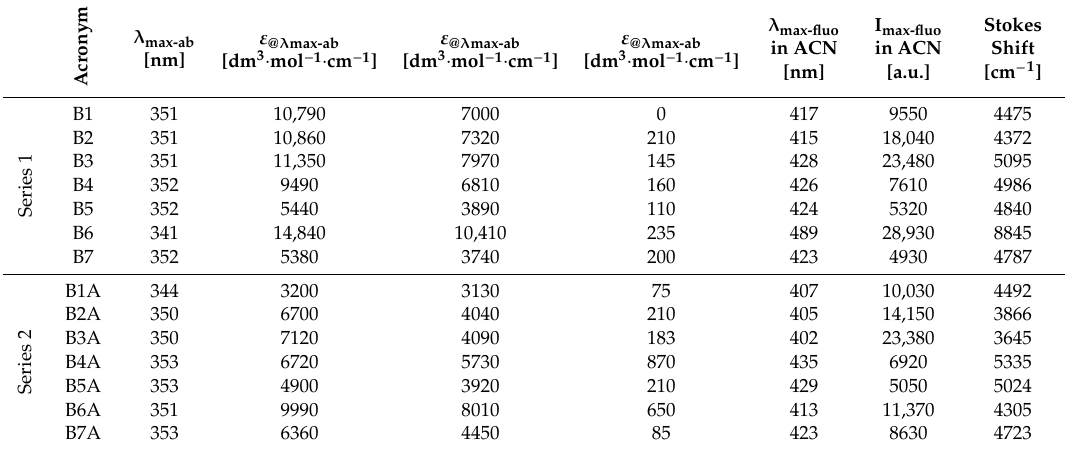
Spectral characteristics of the 2-amino-4-methyl-6-phenyl-benzene-1,3-dicarbonitrile derivatives studied in